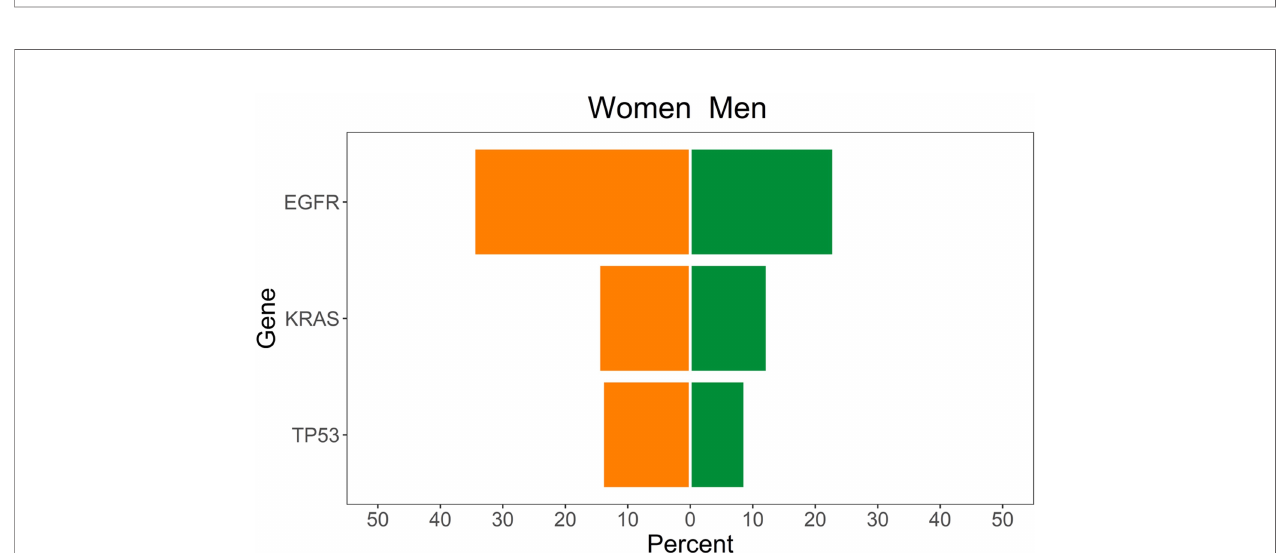
FIGURE 2 | Lung cancer patients with mutations in TP53, KRAS, and EGFR, according to